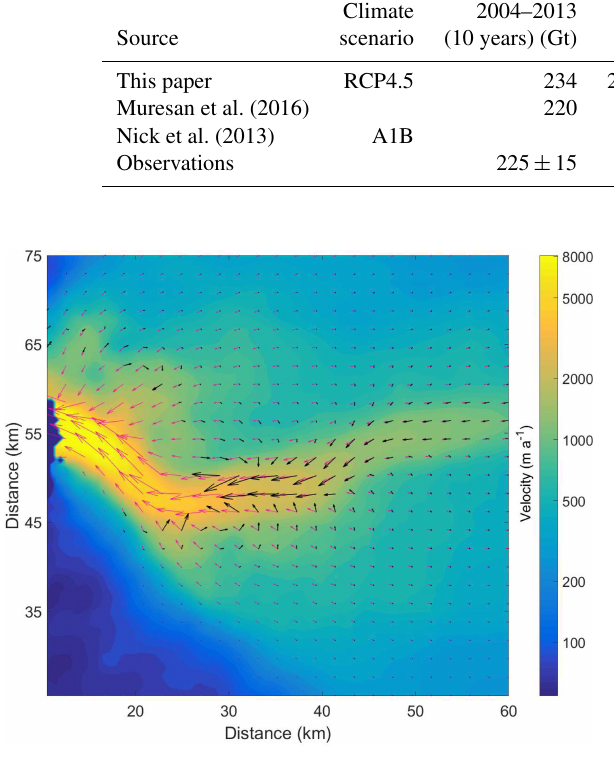
Figure 9. Simulated velocity vectors in 2004 (pink vectors) with their magnitudes (right color bar) and velocity difference between 2004 and 2099 (2099’s minus 2004’s, black vectors), for clarity vec- tor lengths are clipped at 5kma − 1